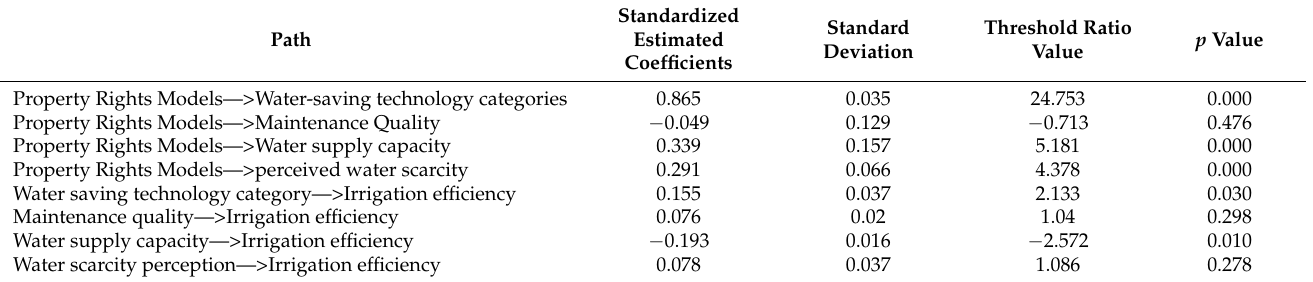
Table 12. Standardized regression coefficient results for path analysis of the impact of property rights development patterns on irrigation efficiency.